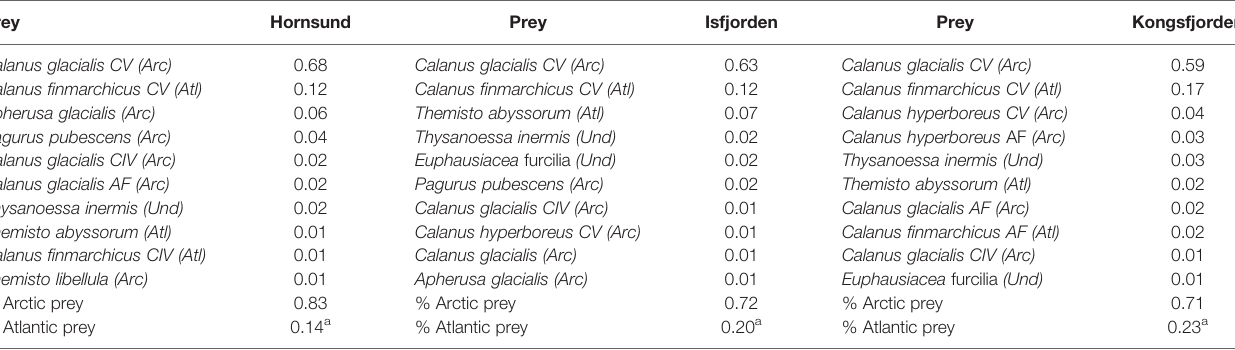
based only on years where data are available in all three fjords. Letters in brackets indicate whether the prey is an Arctic (Arc) or an Atlantic (Atl) species. “ Und ” stands for “ undetermined distribution ” and represents species that cannot be classi fi ed as Arctic or Atlantic. This classi fi cation is based on Hop et al.